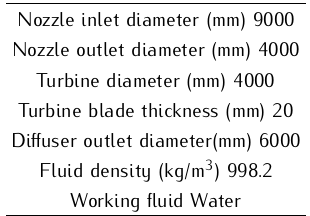
Table 1. Main parameters of the modeled turbine unit.